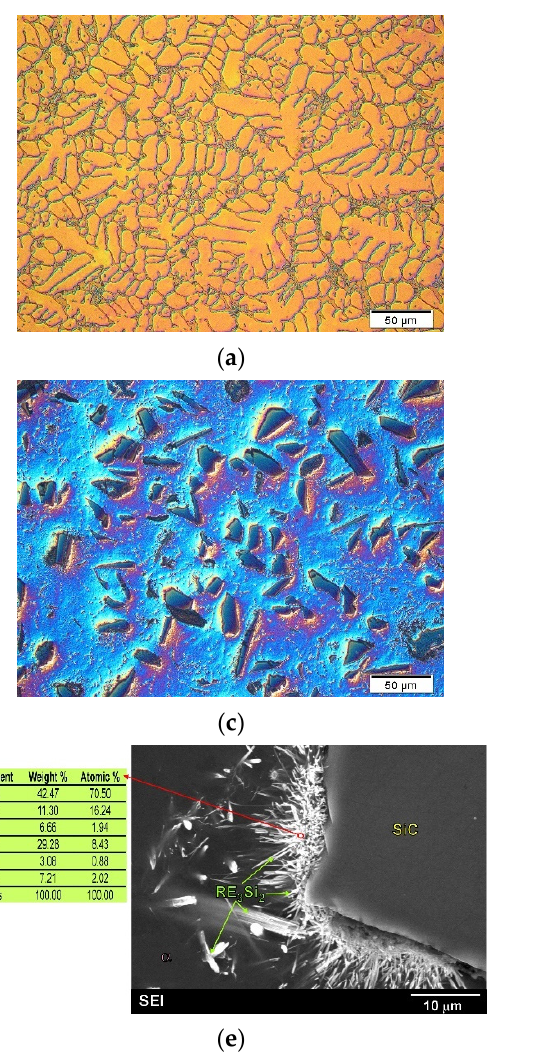
Figure 6. Microstructure of ME3 magnesium alloy. ( a , b ) Micrographs taken at different magnification) and microstructure of ME3 matrix composites with SiC particles. ( c , d ) Micrographs taken at different magnification); ( e ) SEM micrograph of composite microstructure with EDX results from designated point; ( f ) TEM micrograph of interface between components with diffraction pattern from observed RE 3 Si 2 phase.